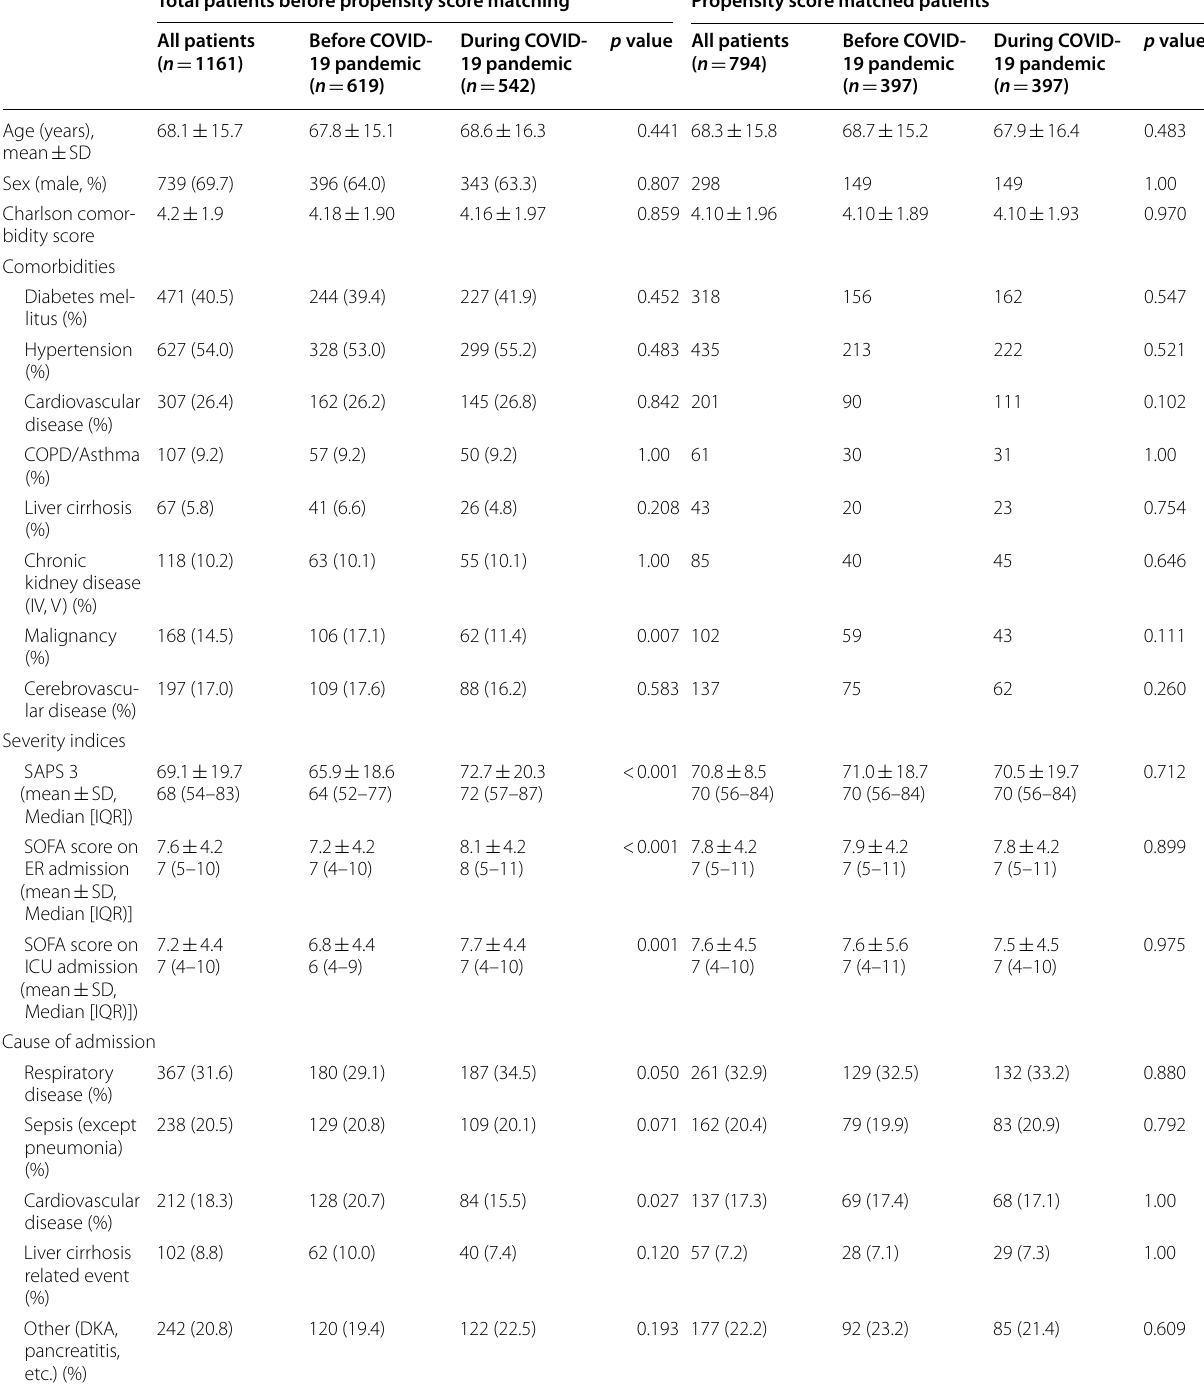
COVID, corona virus disease; ICU, intensive care unit; COPD, chronic obstructive pulmonary disease; SAPS, simplified acute physiology score; SOFA, sequential organ failure assessment; DKA, diabetic ketoacidosis